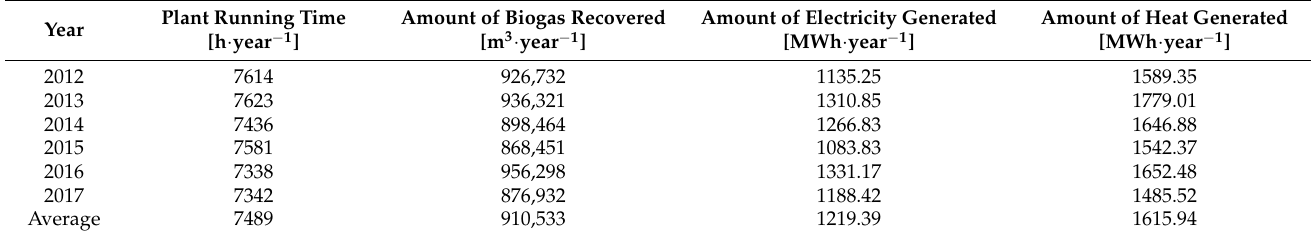
Table 2. CHP plant performance data for 2012–2017.